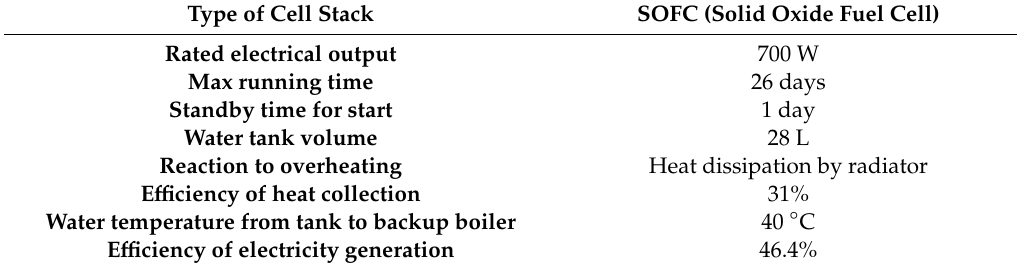
Figure 4. Working principle of the solid oxide fuel cell cogeneration system (SOFC–CGS).